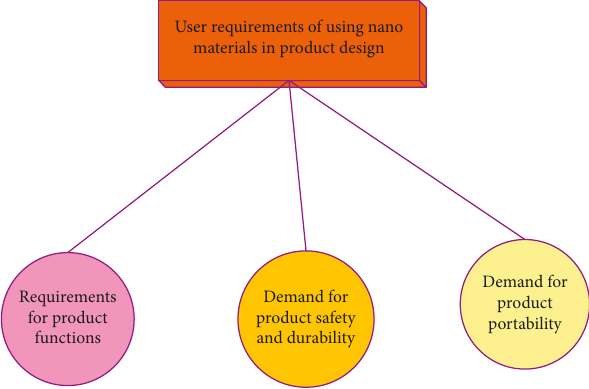
Figure 1: User requirements for using nanomaterials in product